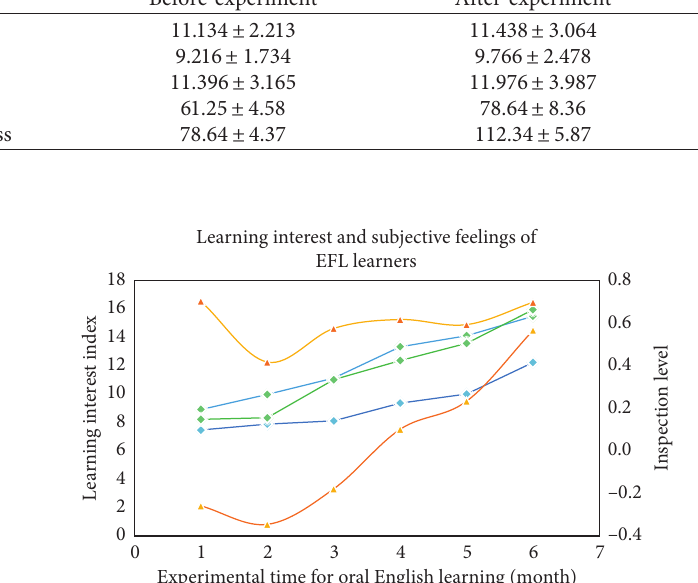
Table 6: EFL learners’ oral English ability and learning interest before and after the experiment. Dimension